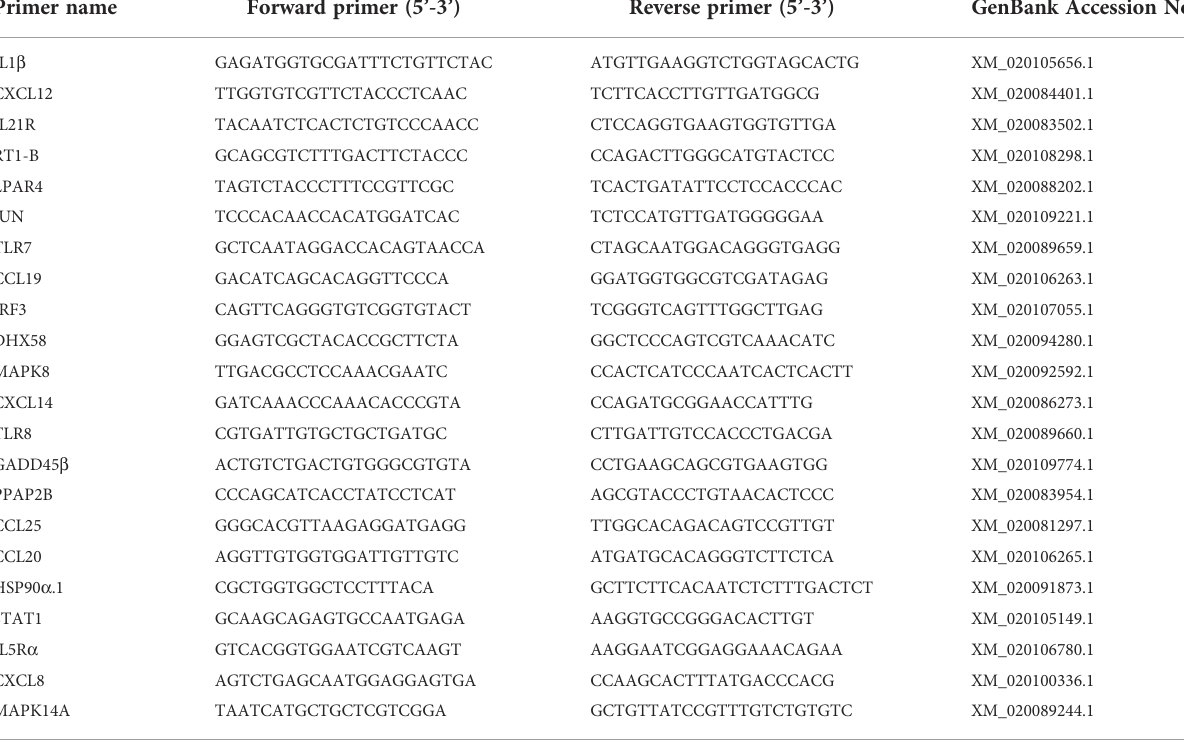
TABLE 1 List of primers for qRT-PCR validation of differentially expressed